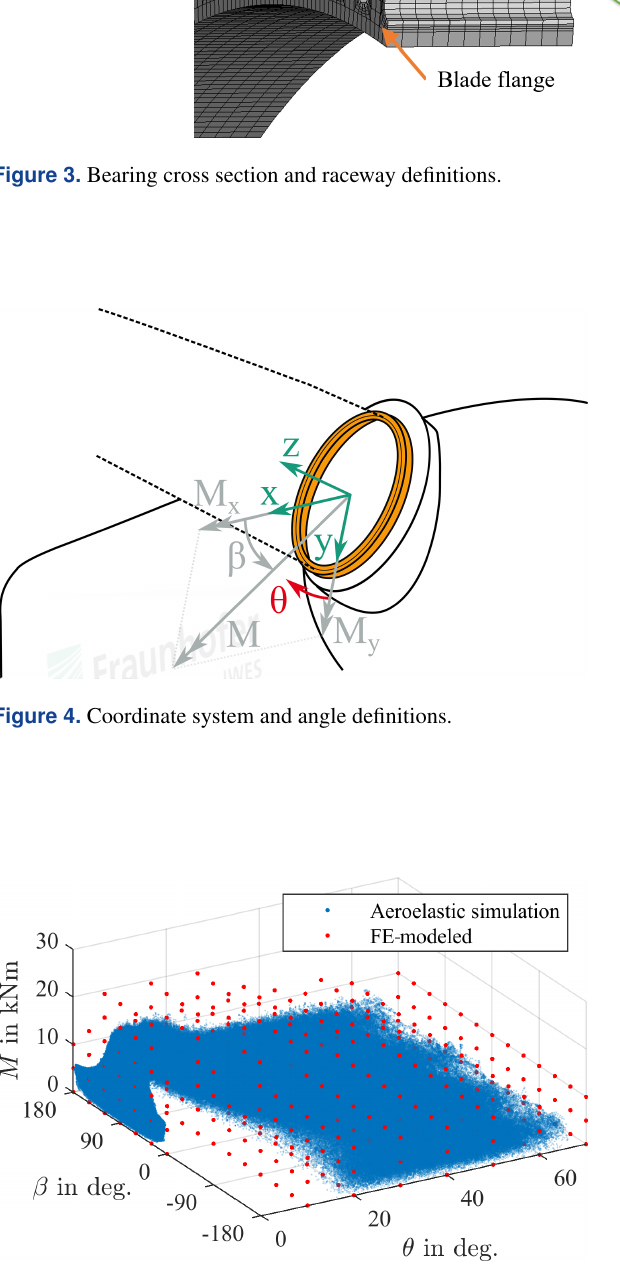
Figure 5. All combinations of pitch angle θ , moment M , and load angle β occurring during aeroelastic simulations and the combina- tions chosen for FE